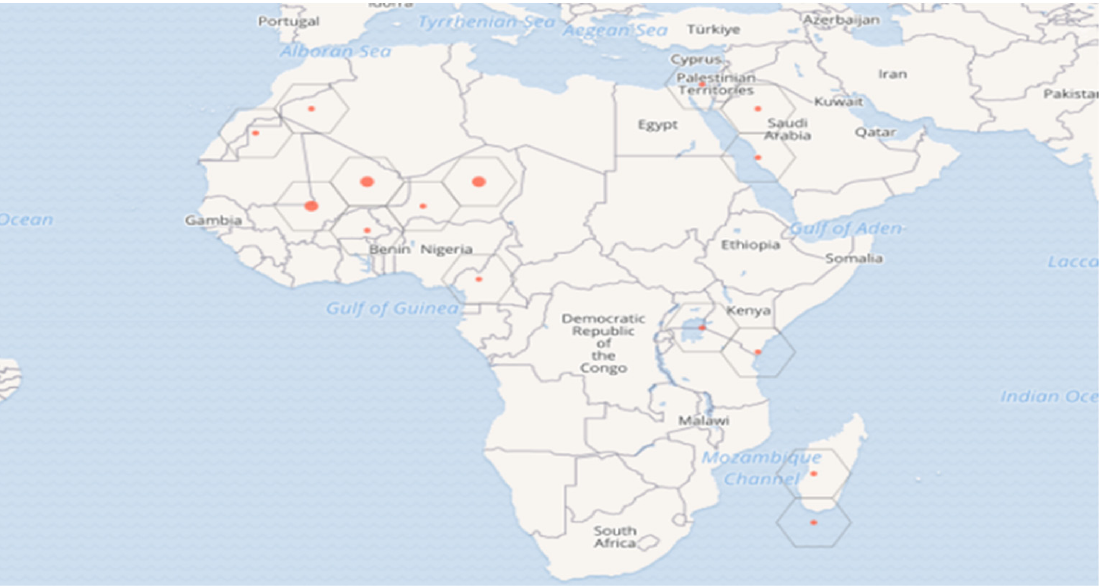
Figure 1. Geographic distribution of V. tortilis. The red dots in the figure legend illustrate the species intensity of distribution.